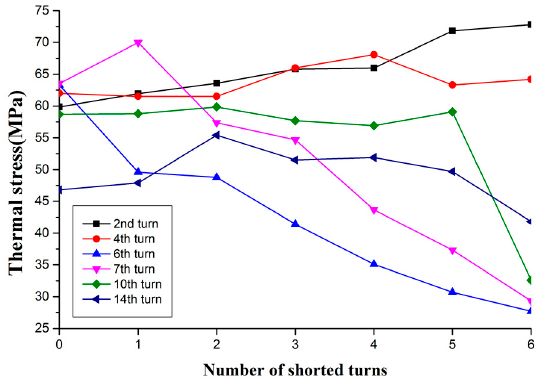
Figure 15. Effect of different numbers of shorted turns on thermal stress of excitation winding.